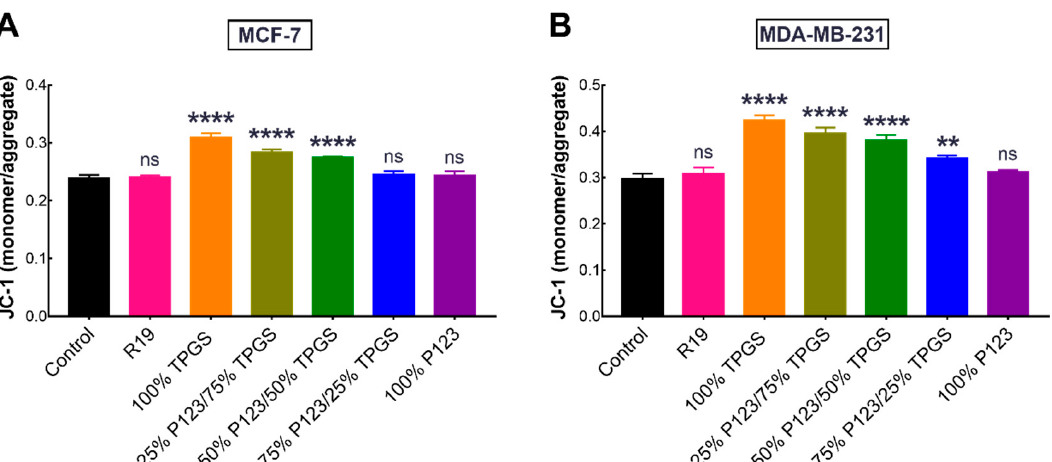
Figure 11. Change in mitochondrial membrane potential of ( A ) MCF-7 and ( B ) MDA-MB-231 cells after 24 h of treatment with 20 µM of R19 and R19-loaded NPs. Results are expressed as the ratio of the green/red fluorescence signals of the JC-1 monomers and aggregates, respectively (mean ± SD; n = 3). ** p < 0.01, **** p < 0.0001, and ns: not significantly different, compared to the control